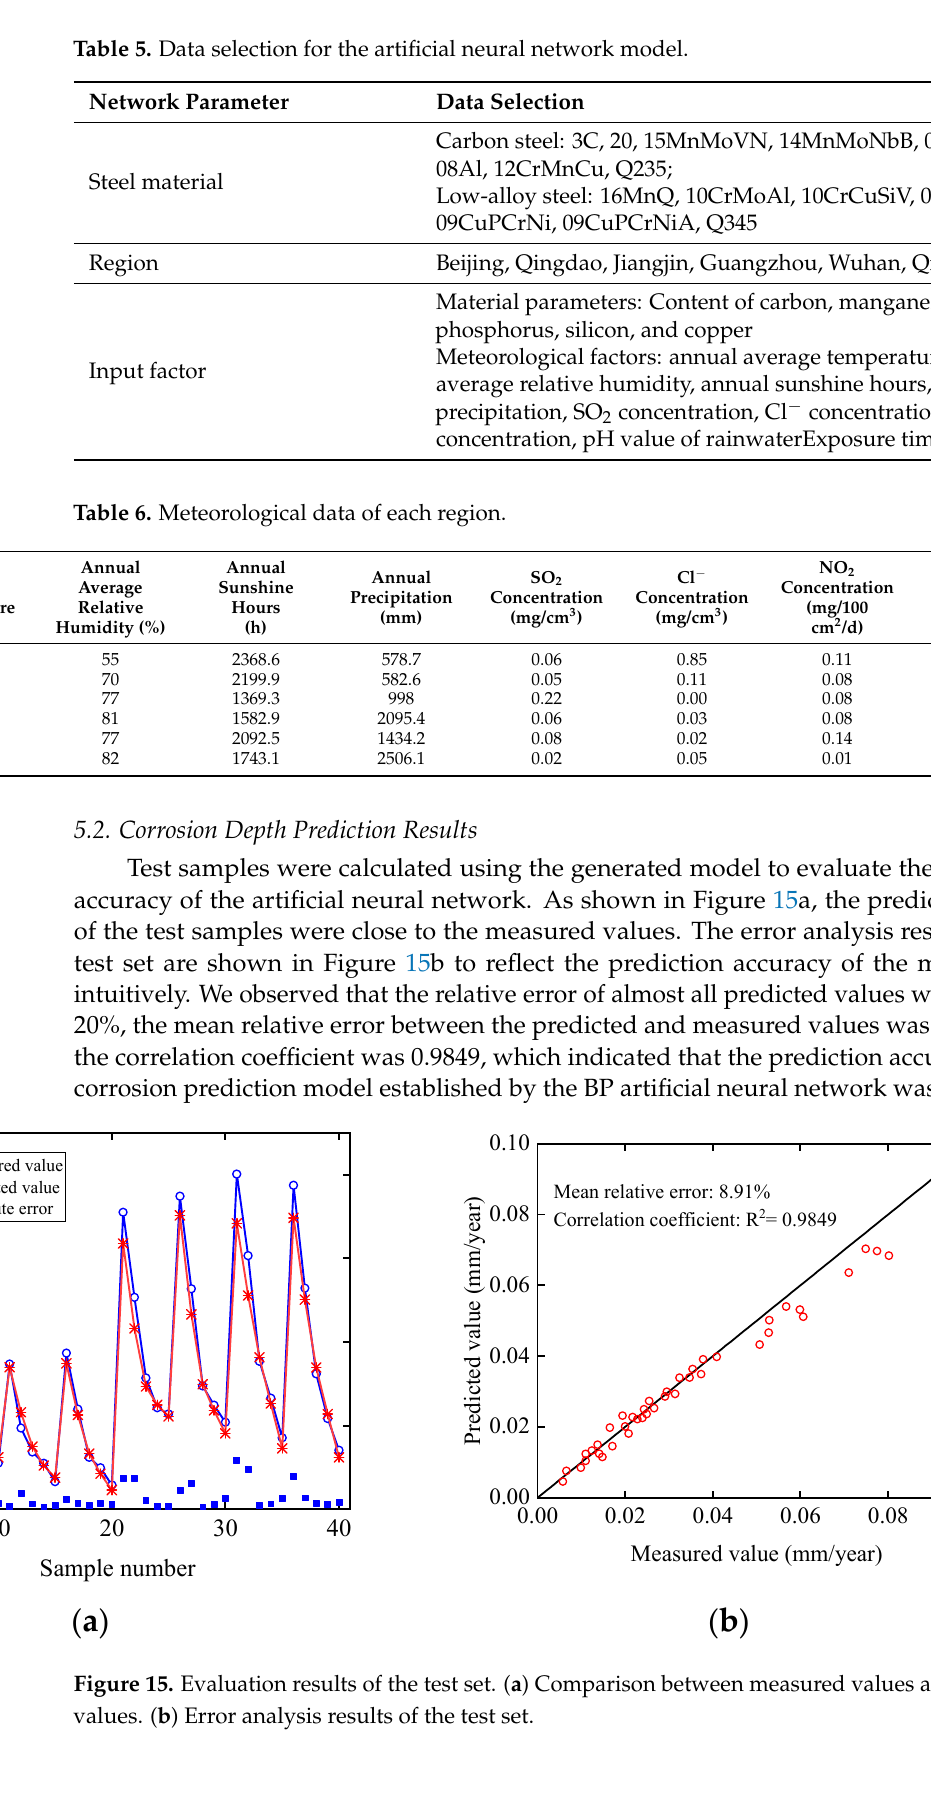
14 of 23 Table 5. Data selection for the artificial neural network model. Network Parameter